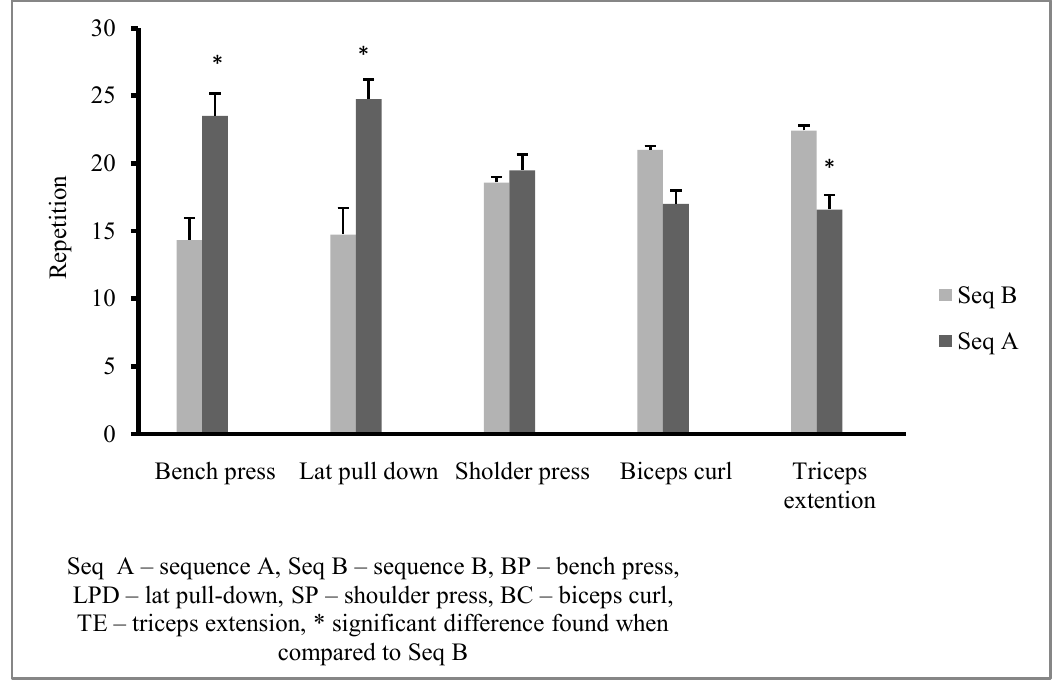
Figure 1. Total Exercise Repetitions at 3-sets for Seq A and Seq B